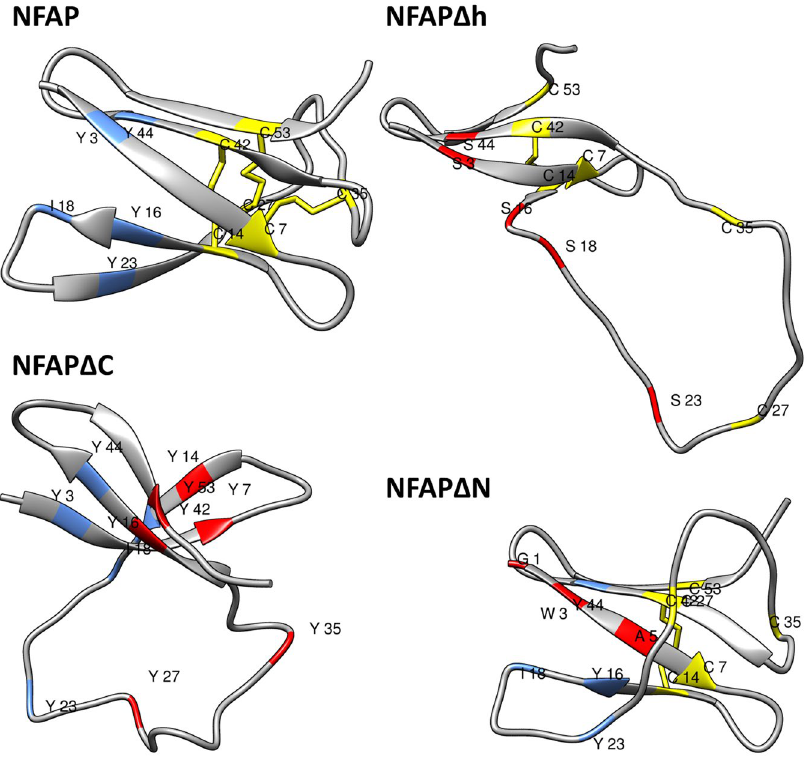
Figure 1. Predicted tertiary structure of NFAP, NFAP Δ C, NFAP Δ h, NFAP Δ N. The hydrophobic core constituting amino acids are indicated by light blue. Cysteines and the possible disulphide bridges are marked with yellow and yellow line. Amino acid substitutions are indicated in red. The putative structures are highly reliable: Based on the Ramachandran plot analysis 37 , 94.5% and 5.5% of the residues are in the favoured and allowed regions at NFAP; and 98.2% and 1.8% at NFAP Δ C, NFAP Δ h, and NFAP Δ N. The.pdb files of the structures are available in the Dataset 1–4. NFAP: Neosartorya fischeri NRRL 181 antifungal protein; NFAP ∆ C: cysteine deletion NFAP mutant; NFAP ∆ h: hydrophobic core deletion NFAP mutant; NFAP ∆ N: N-terminal amino acids exchanged NFAP